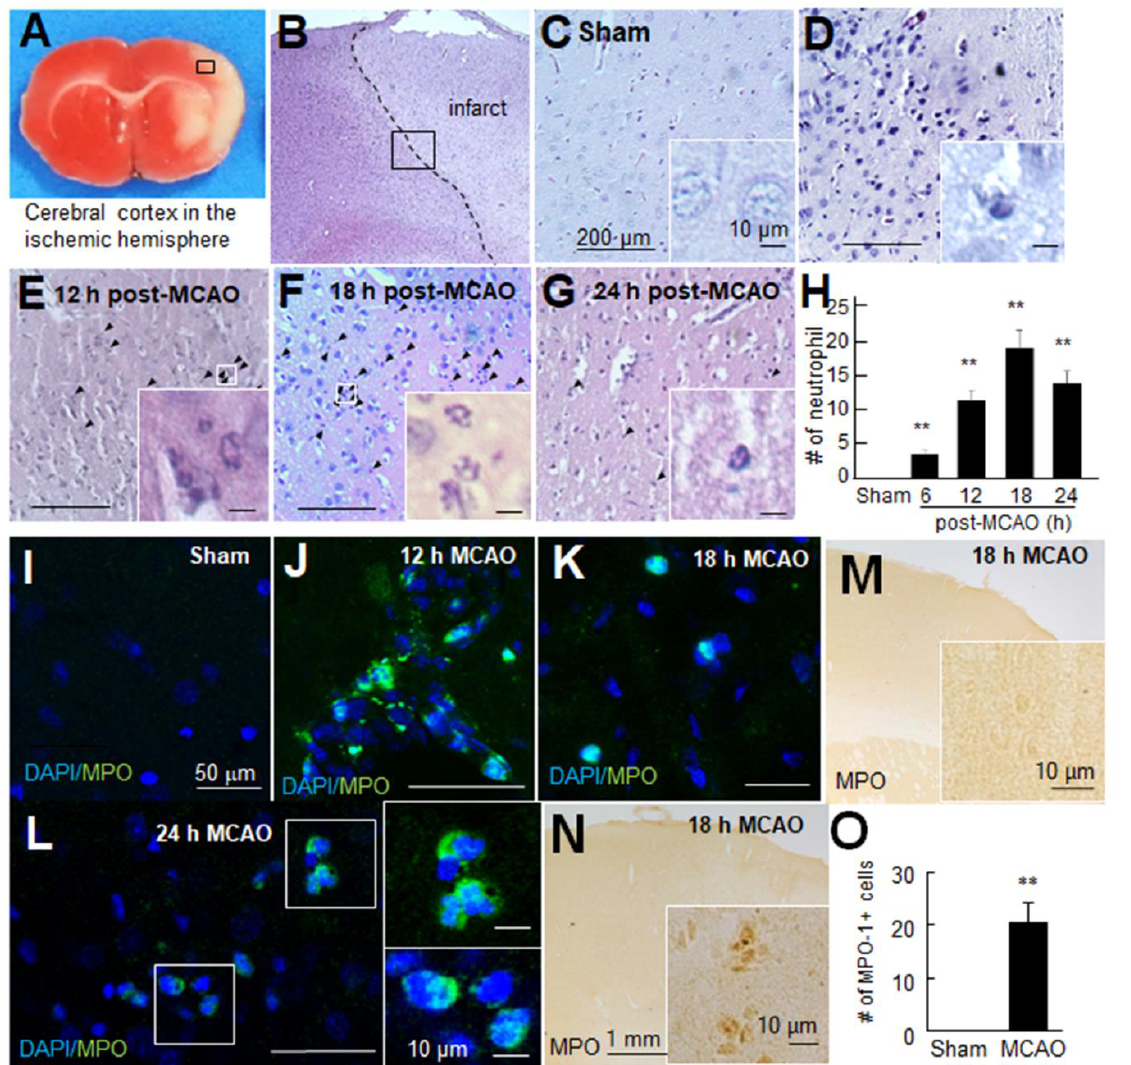
Figure 3. Neutrophils were infiltrated in the post-MCAO brains. ( A – H ) Coronal brain sections were prepared at 6, 12, 18, or 24 h post-MCAO and stained with Hematoxylin and Eosin. Numbers of neutrophils were counted in the cerebral cortex indicated by the black box (0.5 × 0.5 mm 2 ). Representative pictures are shown ( B – G ), and results are presented as mean ± SEM (n = 12 from 3 animals) ( H ). ( I – L ) Coronal brain sections were prepared from the sham-operated control group and MCAO group at 12, 18, or 24 h post-MCAO and stained with anti-myeloperoxidase (MPO) antibody and 4 (cid:48) ,6-diamidino-2-phenylindole (DAPI). Representative pictures of the cortex are shown. ( M – O ) Coronal brain sections were prepared from the sham control group and MCAO group at 18 h post-MCAO and stained with anti-MPO antibody, and numbers of MPO-positive cells were counted in the indicated black box (0.5 × 0.5 mm 2 ). Scale bars in ( C – G ) and ( I – L ) represent 200 and 50 µ m, respectively, and those in insets represent 10 µ m. Sham, sham-operated rats; MCAO, PBS-treated MCAO controls. ** p < 0.01 vs. sham control by one-way ANOVA with Student–Newman–Keuls